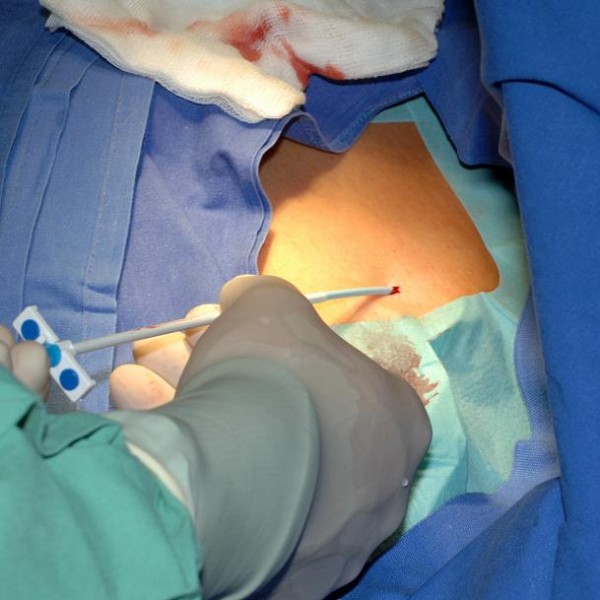
Puncture of V. Subclavia – introducing peel away sheath.